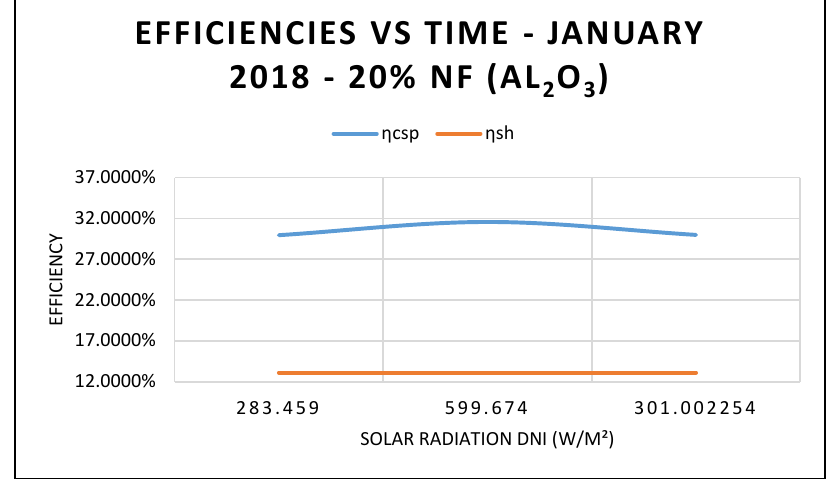
Figure 11. E ffi ciencies of the CSP collector and hybrid system at di ff erent radiations and at a Figure 11 Efficiencies of the CSP collector and hybrid system at different radiations and at a concentration of 20% Al 2 O 3. concentration of 20% Al 2 O 3.